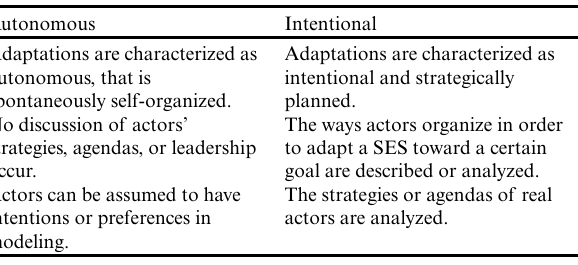
Table 1 . Coding of research question 1, autonomous vs. intentional. Each row represents sufficient but not necessary conditions